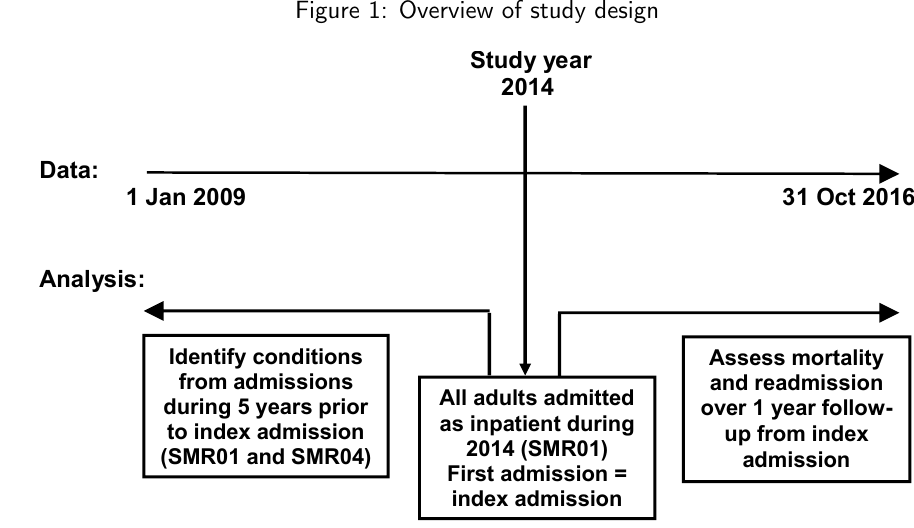
Figure 1: Overview of study design